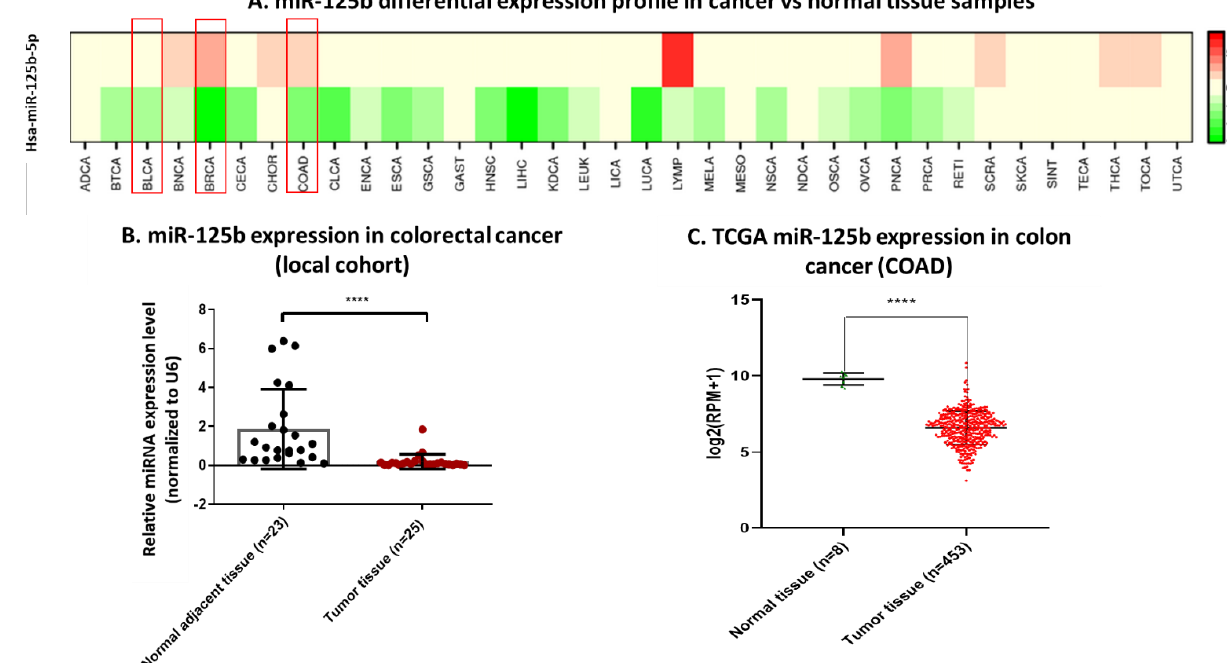
Figure 1. Screening of miR-125b expression in cancer, with a focus on colon malignancies. ( A ) miR-125b-5p expression screening across cancer types; data retrieved from dbDEMC (database of Differentially Expressed MiRNAs in human Cancers). Within the red squares there are the three in depth analyzed cancer types: breast cancer (BRCA), bladder cancer (BLCA), and colon cancer (COAD). ( B ) RT-qPCR results of miR-125b-5p expression in colon cancer tissue samples ( n = 25) versus normal adjacent tissue samples ( n = 23) (data presented as mean ± S.D.; **** p < 0.0001, two-tailed Mann–Whitney test). Experiments including the local cohorts of patients were performed in duplicate for each sample and miR-125b-5p relative expression was expressed by fold-change and normalized to U6 snRNA ( C ) Validation of miR-125b-5p expression (RNASeq count) on COAD cohort from TCGA database in tumor tissue ( n = 453) compared to normal ones ( n = 8) (data presented as mean ± S.D.; **** p < 0.0001, two-tailed Mann–Whitney test).